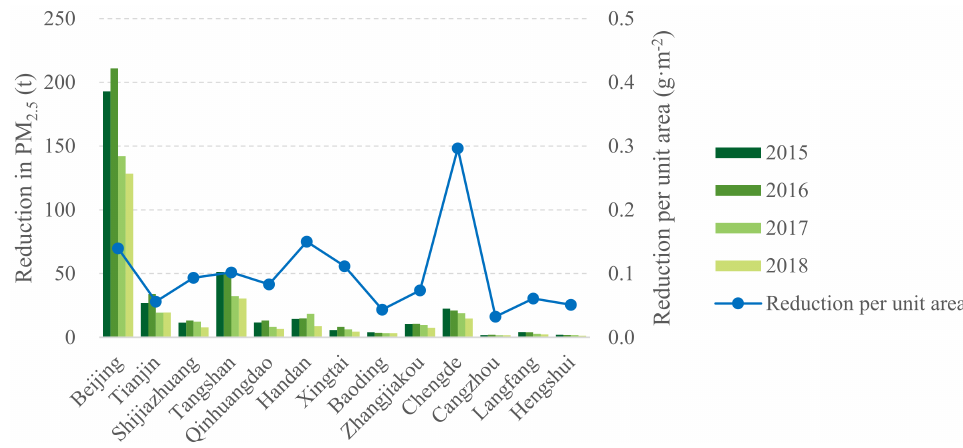
Figure 16. PM 2.5 removal of each city at the built-up area scale from 2015 to 2018.